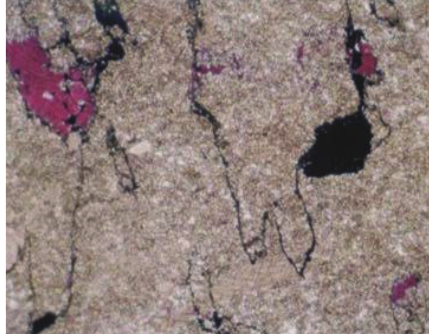
Figure 14: Silty dolomite, S2, 3648.94 ∼ 3649.23 m, T 1 j 2